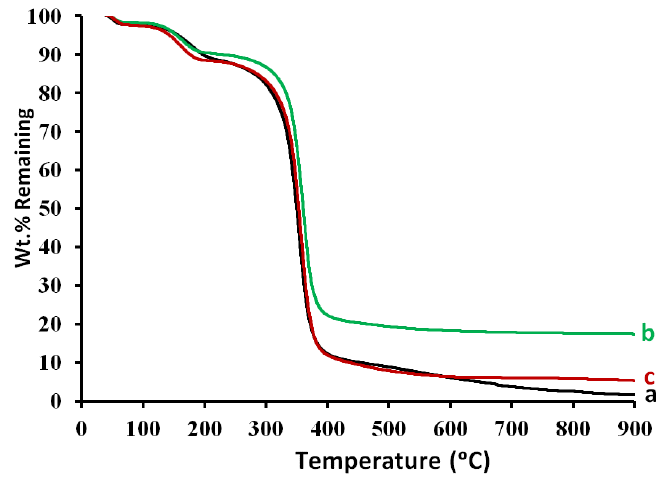
Figure 11. TGA of the blank cellulose acetate (CA) membrane ((a) blank CAP W) and the magnetic mixed CA matrix membranes ((b) CAP1090 W and (c) CAP2080 W). For the membrane dope, 0.1 wt.% of lithium chloride and poly(methylmethacrylate) (PMMA; 0.8 wt.%) were used.